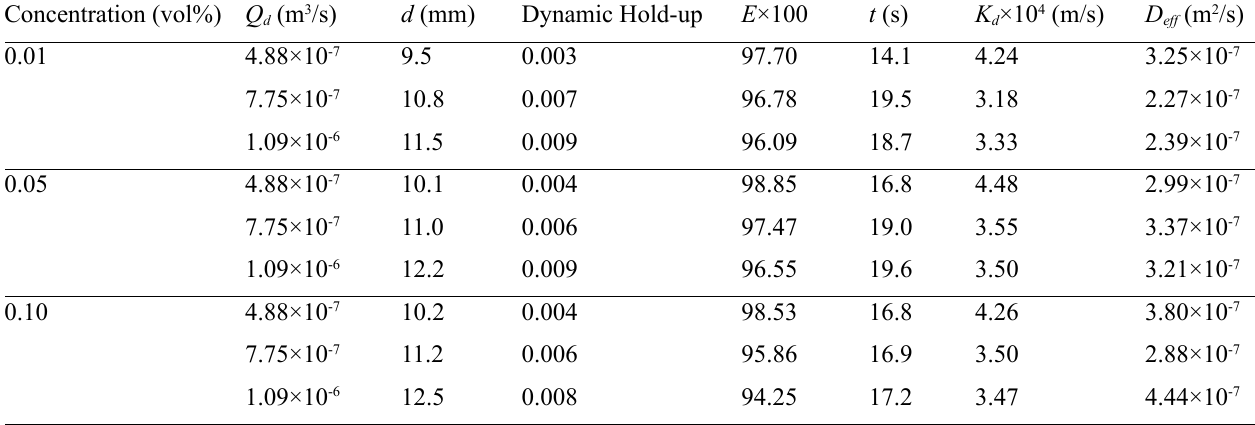
Table 6. Experimental data for mass transfer coefficients of ZrO